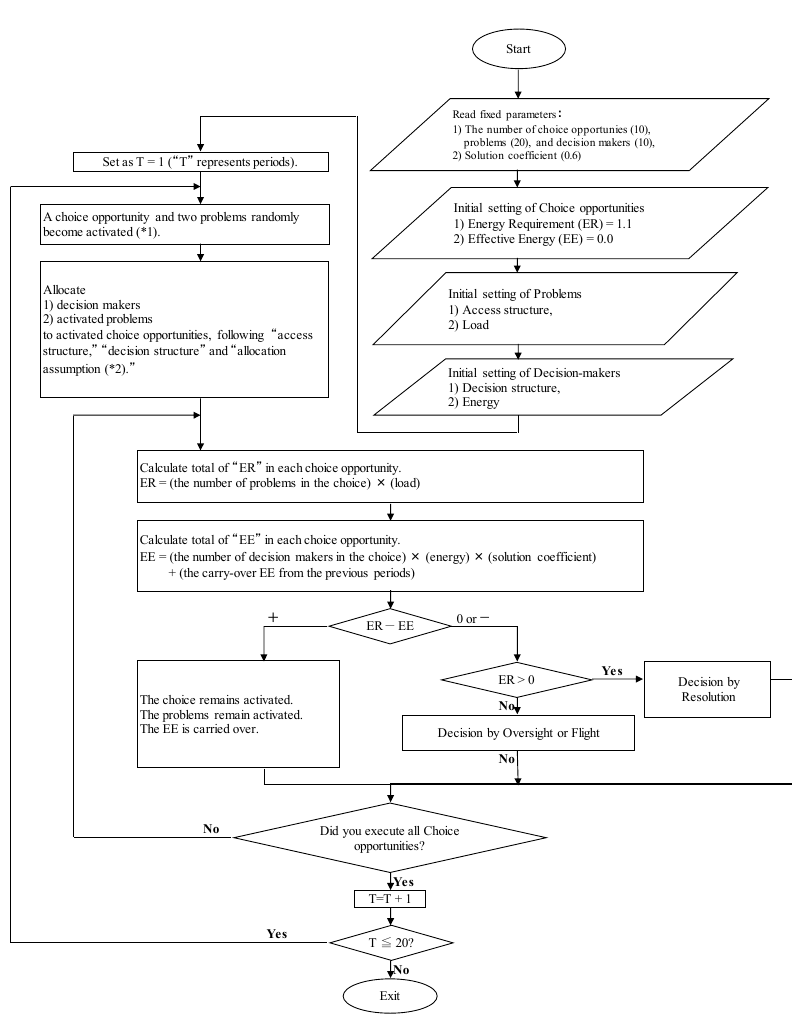
Figure 1. Flow chart of the original simulation